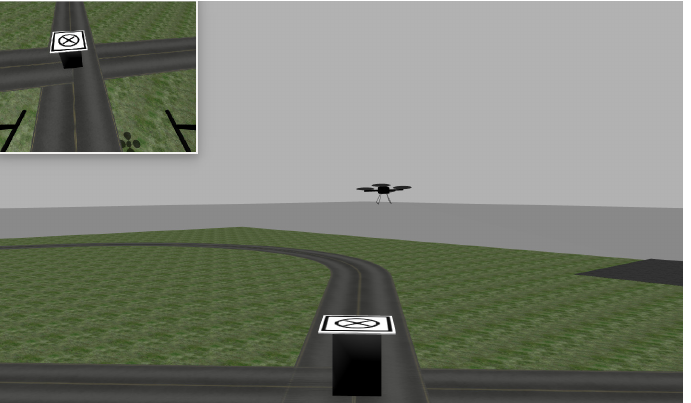
Figure 8. A snapshot of the Gazebo simulation. The quadrotor’s camera view is shown in the top left